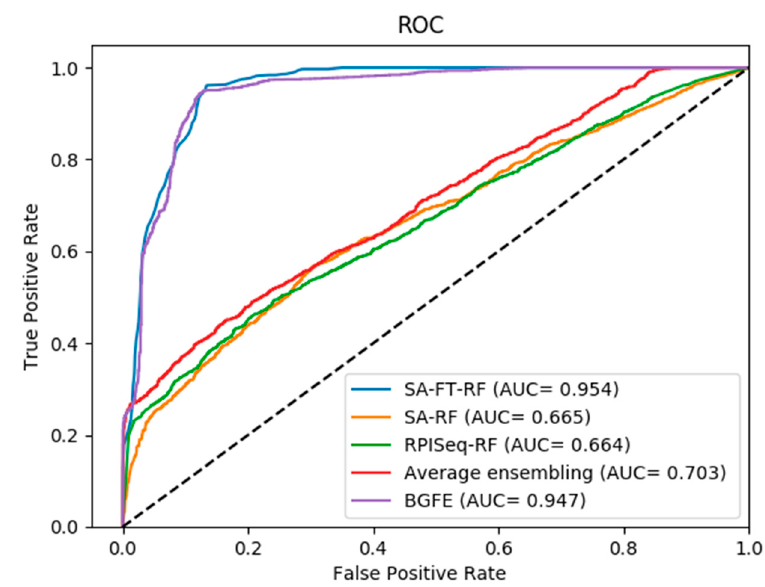
Figure 4. ROC curves of performance comparisons between BGFE and other strategies on dataset RPI2241.